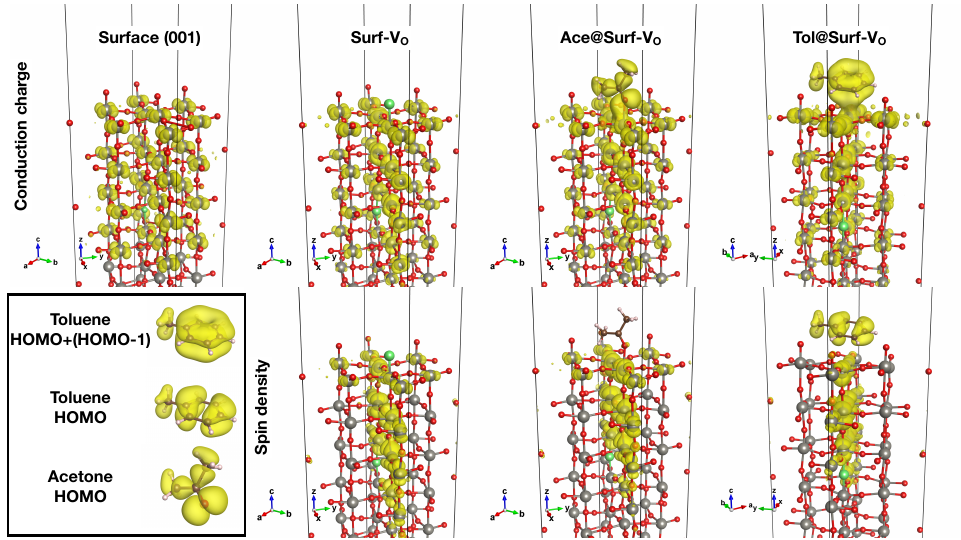
Figure 6. Conduction charge densities ( upper row ) and spin densities ( lower row ) of some of the considered systems. Charge densities of the relevant states of the isolated molecules are reported in the box. The vacancy sites are reported in green.